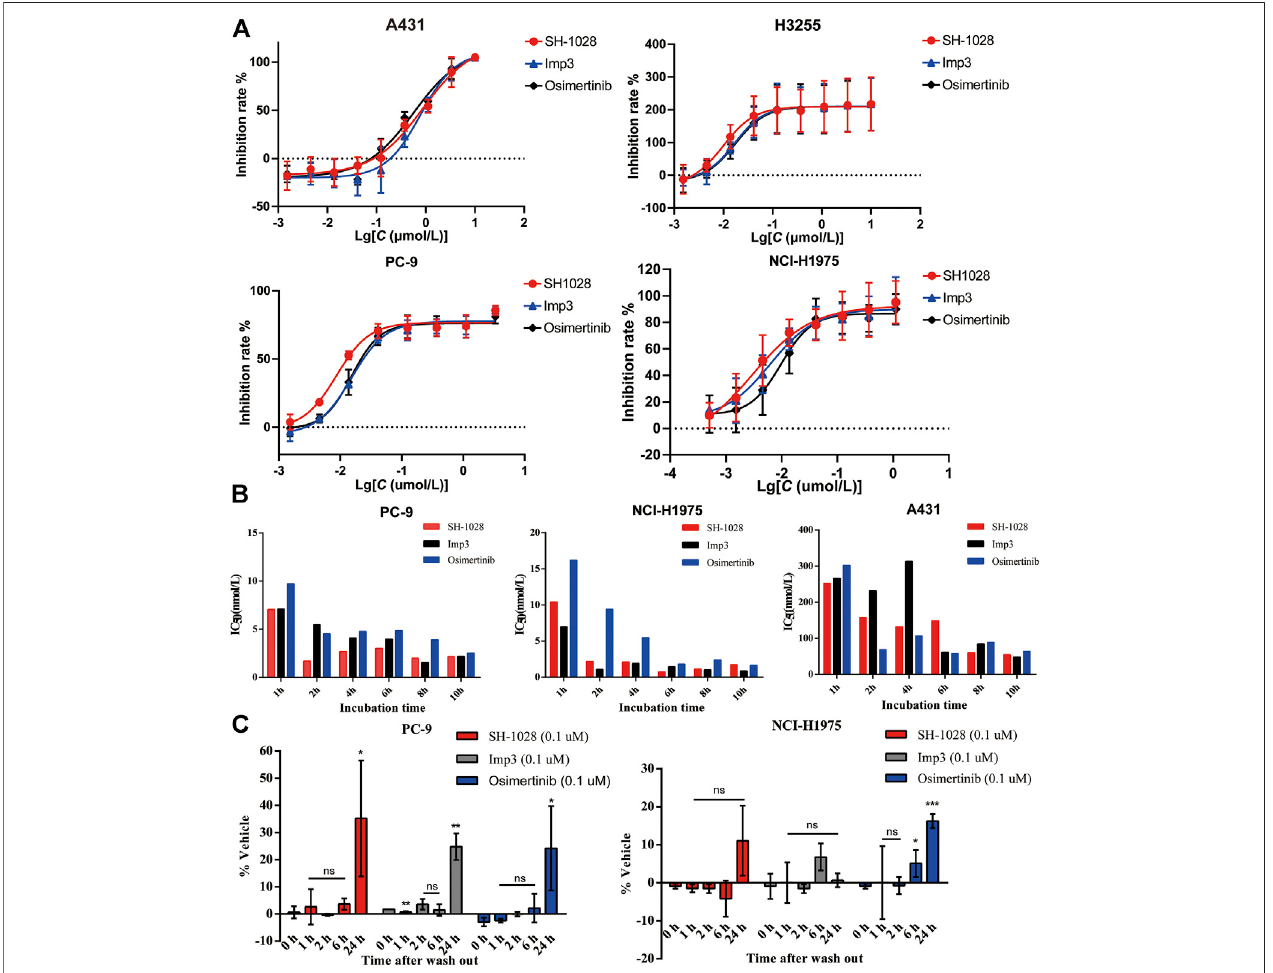
FIGURE2| Theef fi cacyofSH-1028 incelllines.( A ) Theantiproliferativecapabilities ofSH-1028 toA431(EGFR WT ),H3255 (EGFR L858R ),PC-9 (EGFR d746 – 750 )and NCI-H1975 (EGFR L858R/T790M ).( B ) Time-dependentinhibitionofEGFRphosphorylationinPC-9, NCI-H1975 andA431.( C )Inhibition ofEGFRphosphorylation.after the drugwashoutinPC-9andNCI-H1975.Datawereexpressedasmean( n (cid:1) 2; B )andmean ± SD( n (cid:1) 3; A and C );* p < 0.05vs.0 h;** p < 0.01vs.0 h;*** p < 0.001vs.0 h; ns: no signi fi cant difference vs. 0